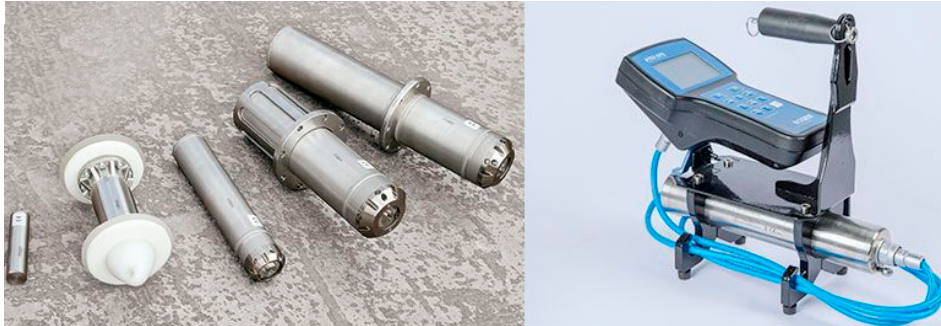
Figure 4. PIG transmitter and PIG tracking & locating receiver.